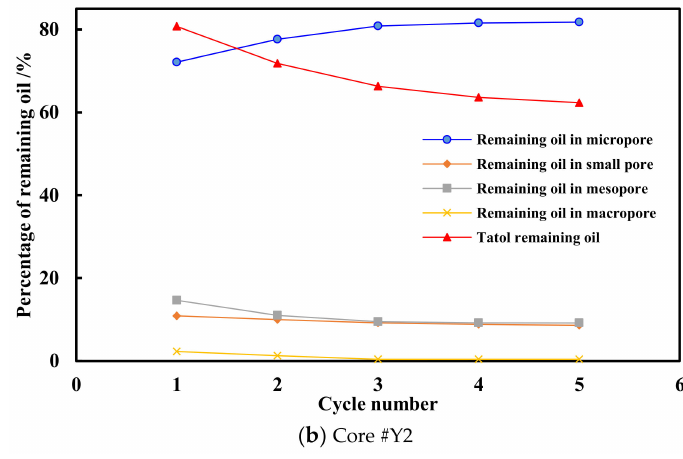
Figure 13. Percentage of remaining oil in different pore scales.